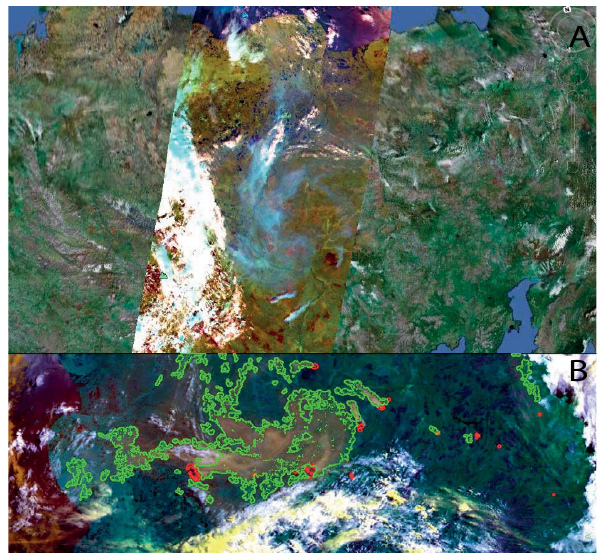
Fig. A1. (A) Context Image showing Google Earth background and AATSR superimposed on top. AATSR image acquired 20 July 2010 at 01:07:53UTC. (B) AATSR false colour composite showing SPM boundary (green) and MODIS FIRMS fire location (red). Image ro- tated counter-clockwise with respect to (A) with north at